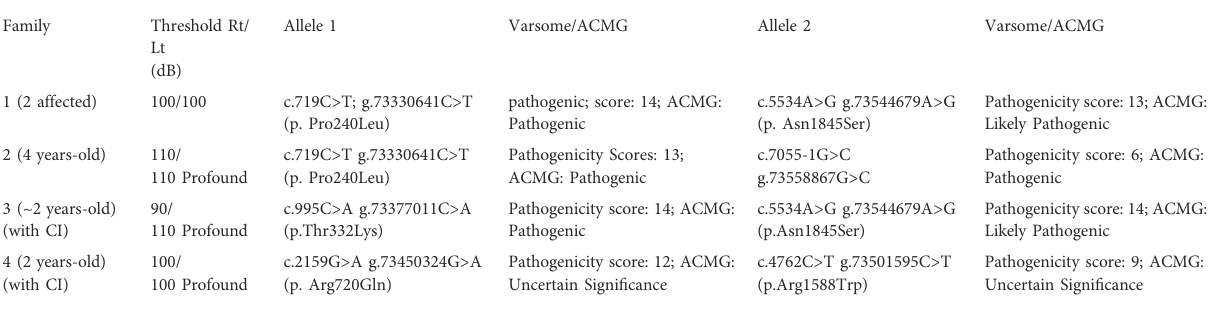
TABLE 1 Evaluation of seven different CDH23 mutations identi fi ed in fi ve patients with hearing loss. Family